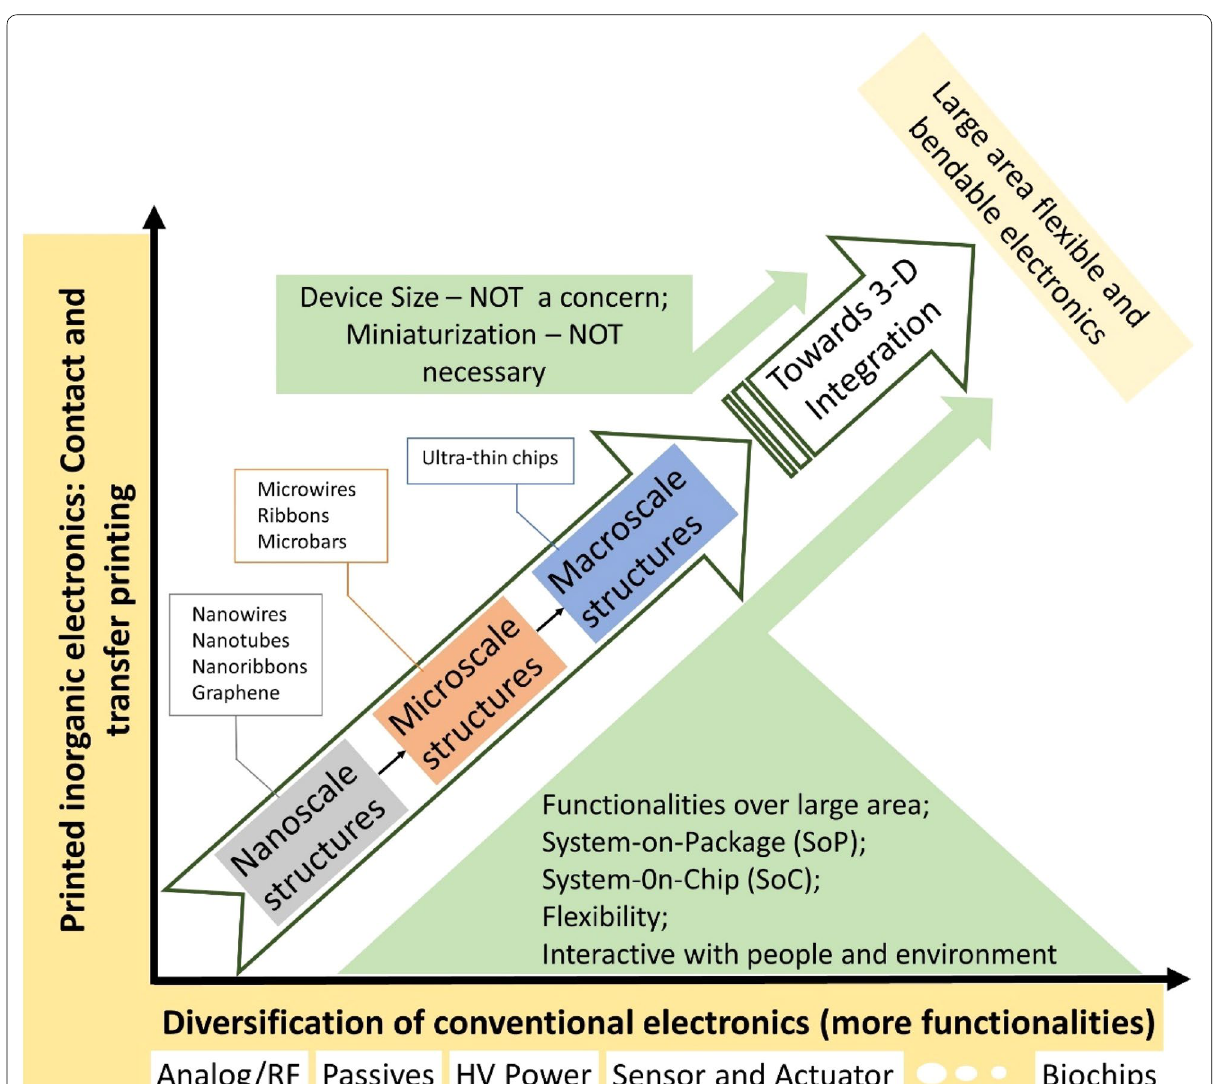
Fig. 15 Printed electronics enabled higher diversification and functionalities than conventional electronics including biochips, microelectromechanical sensors, power electronic, analog/RF devices in large area electronics. Printing technologies developed and exploited to provide versatile routes for assembly of nano to macro scale to 3D integration of inorganic functional materials/inks into well-organized arrangements onto various substrates for large area, high performance, flexible inorganic